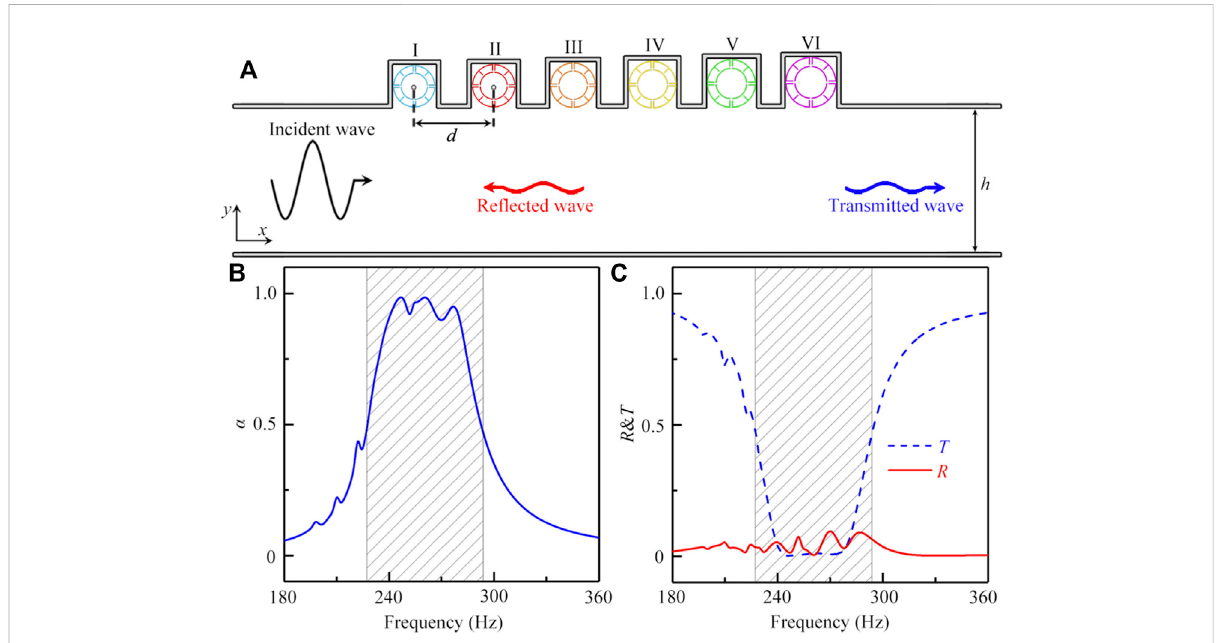
FIGURE 5 (A) Schematic of the open tunnel with 6 unit cells. The parameters t and w of the unit cells are fi xed at 1.2 and 2.0 mm, and the diameters of the unit cells I-VI are